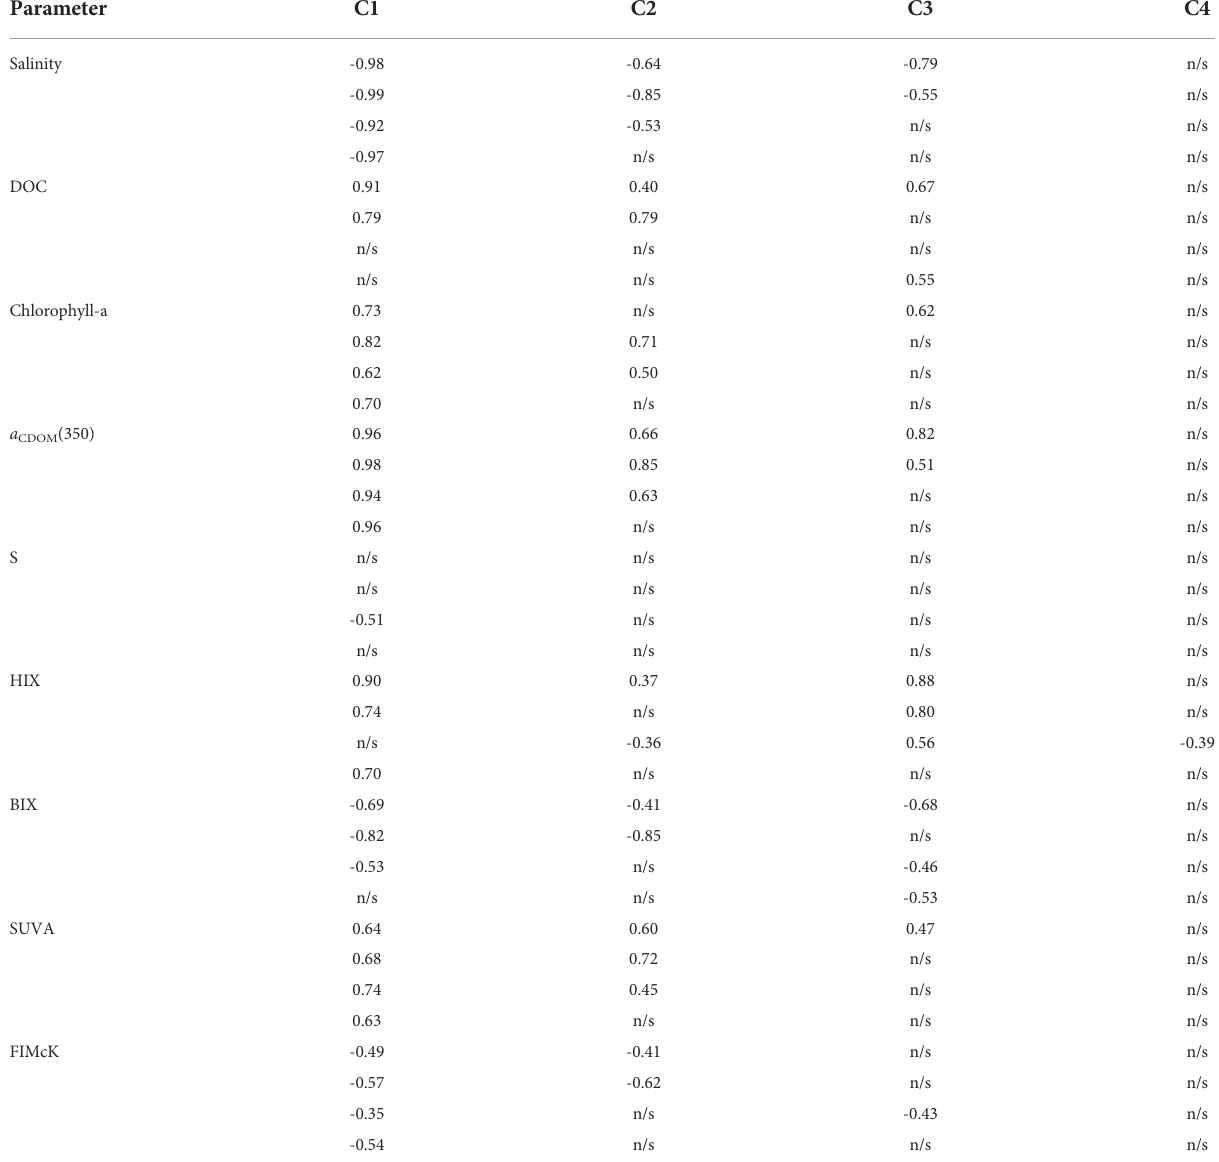
TABLE 3 Pearson ’ s correlation coef fi cients signi fi cant at 0.05 level for PARAFAC components C1 – C4 against various characteristics of seawater.